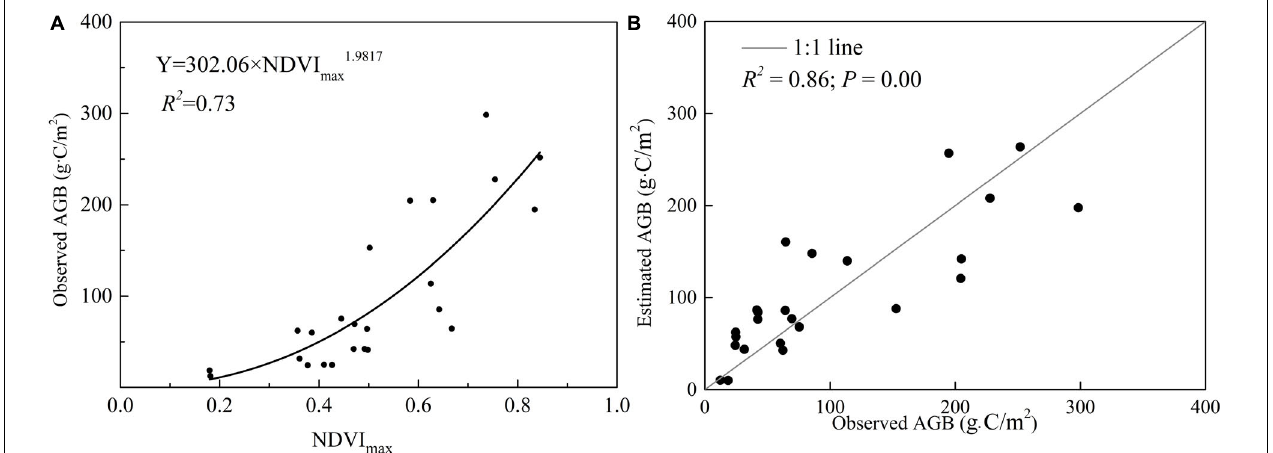
FIGURE 2 | Equation between observed AGB and NDVI max of marsh vegetation (A) and relationship between observed AGB and estimated AGB (B) in the marsh of western Songnen Plain.